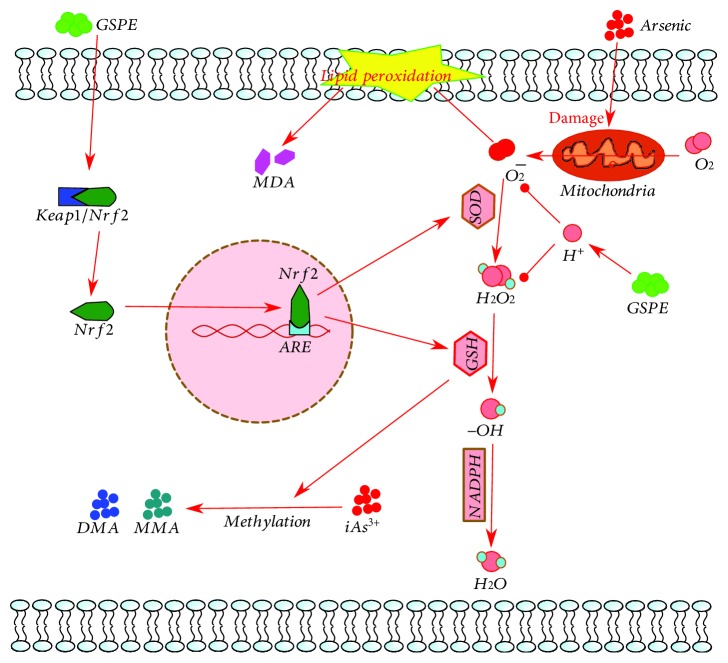
The action mechanism of GSPE on oxidative stress induced by arsenic and methylation of arsenic. Arsenic can cause oxidative injuries by reducing the activity of antioxidative enzymes and increasing the amount of peroxide products. GSPE contains many phenolic hydroxyl groups and release H+, which can bind active oxygen radicals and competitively block the reaction chains of free radicals, reducing the consumption of antioxidants and increasing the activity of antioxidant enzymes. In addition, GSPE promotes the dissociation of Nrf2 and Keap1 proteins, allowing Nrf2 to enter the nucleus from the cytoplasm, thus promoting the expression of downstream genes of Nrf2 and increasing the antioxidant capacity. The Nrf2 pathway activation increases the level of GSH, which promotes the methylation of arsenic (arrows: promotion; blunt arrows: inhibition).